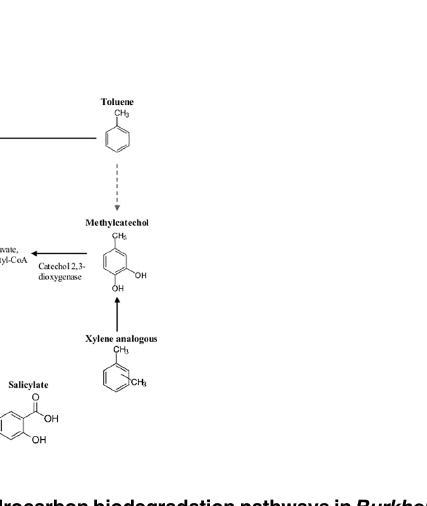
S3 Fig. Result of RT-PCR of MAH degradation genes of Burkholderia sp. K24.